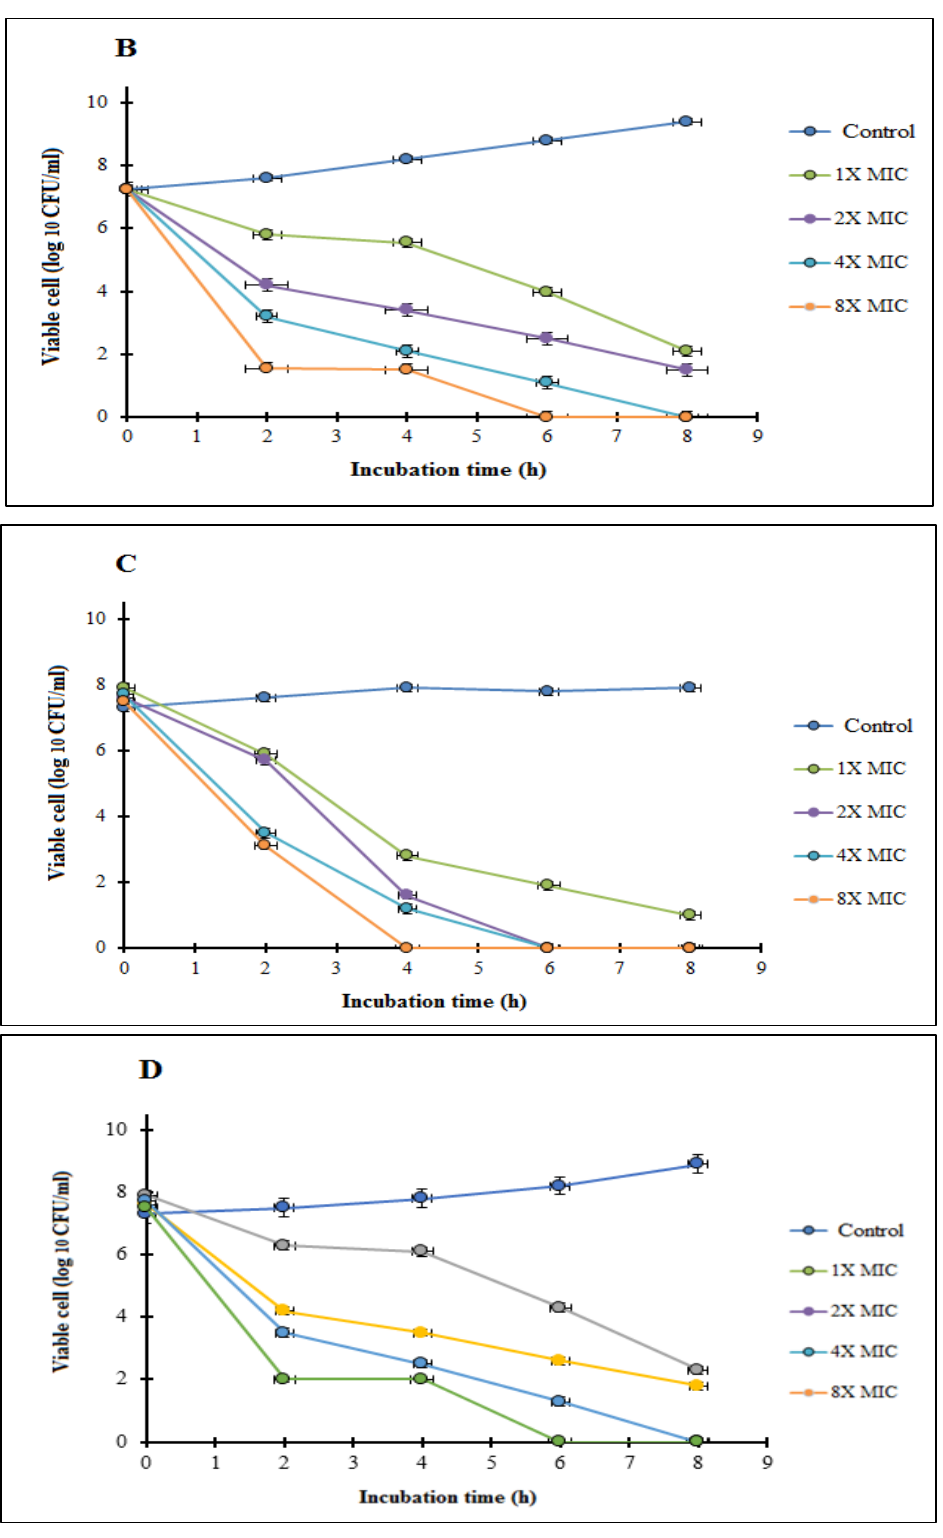
Figure 6. Time-kill plots of Chi/AuNPs against human pathogenic bacterial strains A: Staphylococcus aureus ( A ), Pseudomonas aeruginosa ( B ), Bacillus subtilis ( C ), and Klebsiella oxytoca ( D ) at different concentra- tions and time length. The experiment was performed in triplicate and a graph of the log CFU/mL was plotted against